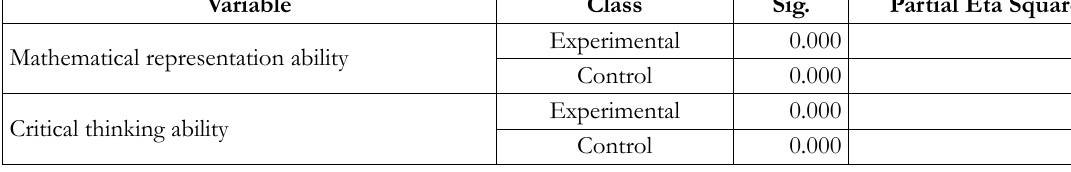
Table 17. Contribution of effective variable of mathematical representation and critical thinking